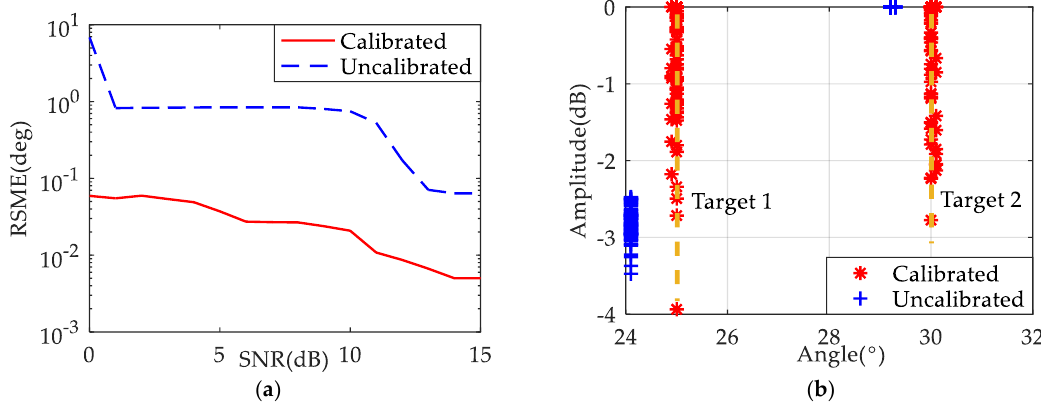
Figure 12. ( a ) The RSME of DOA results; ( b ) The DOA results of 100 Monte Carlo experiments.